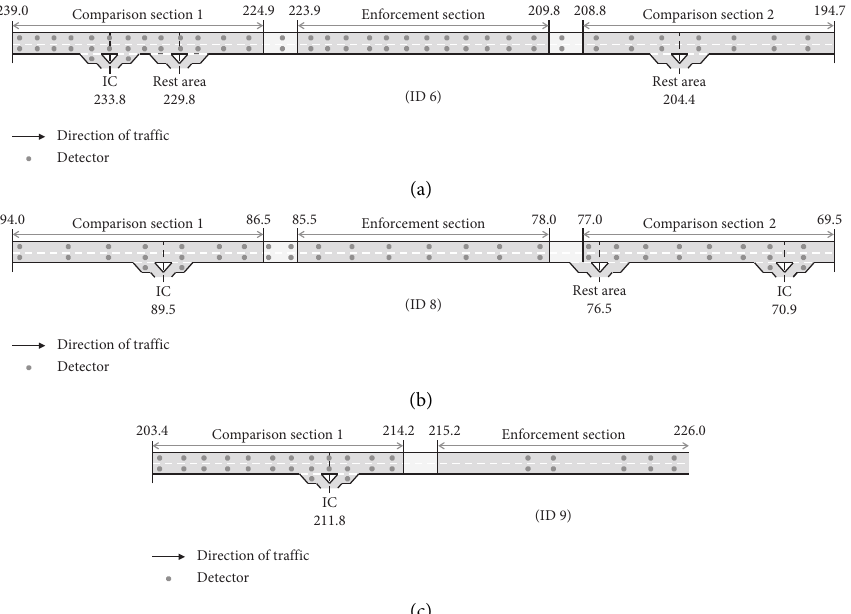
Figure 2: Illustrations of layouts of study and control sections: (a) Jungbunaeruk, (b) Daejeon-Tongyeong, and (c) Yeongdong III (not to scale).